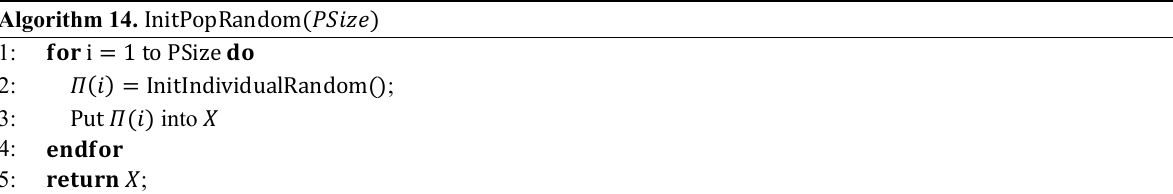
Algorithm 14. InitPopRandom( 𝑃𝑆𝑖𝑧𝑒